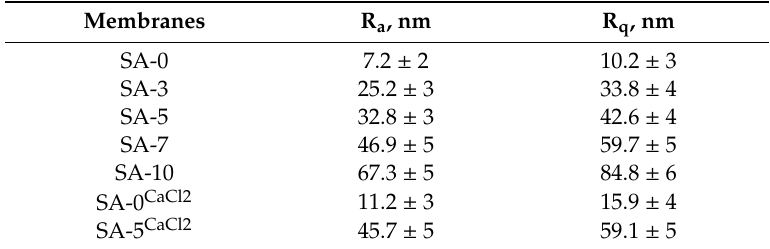
Table 4. Surface parameters of dense SA and SA–fullerenol membranes.